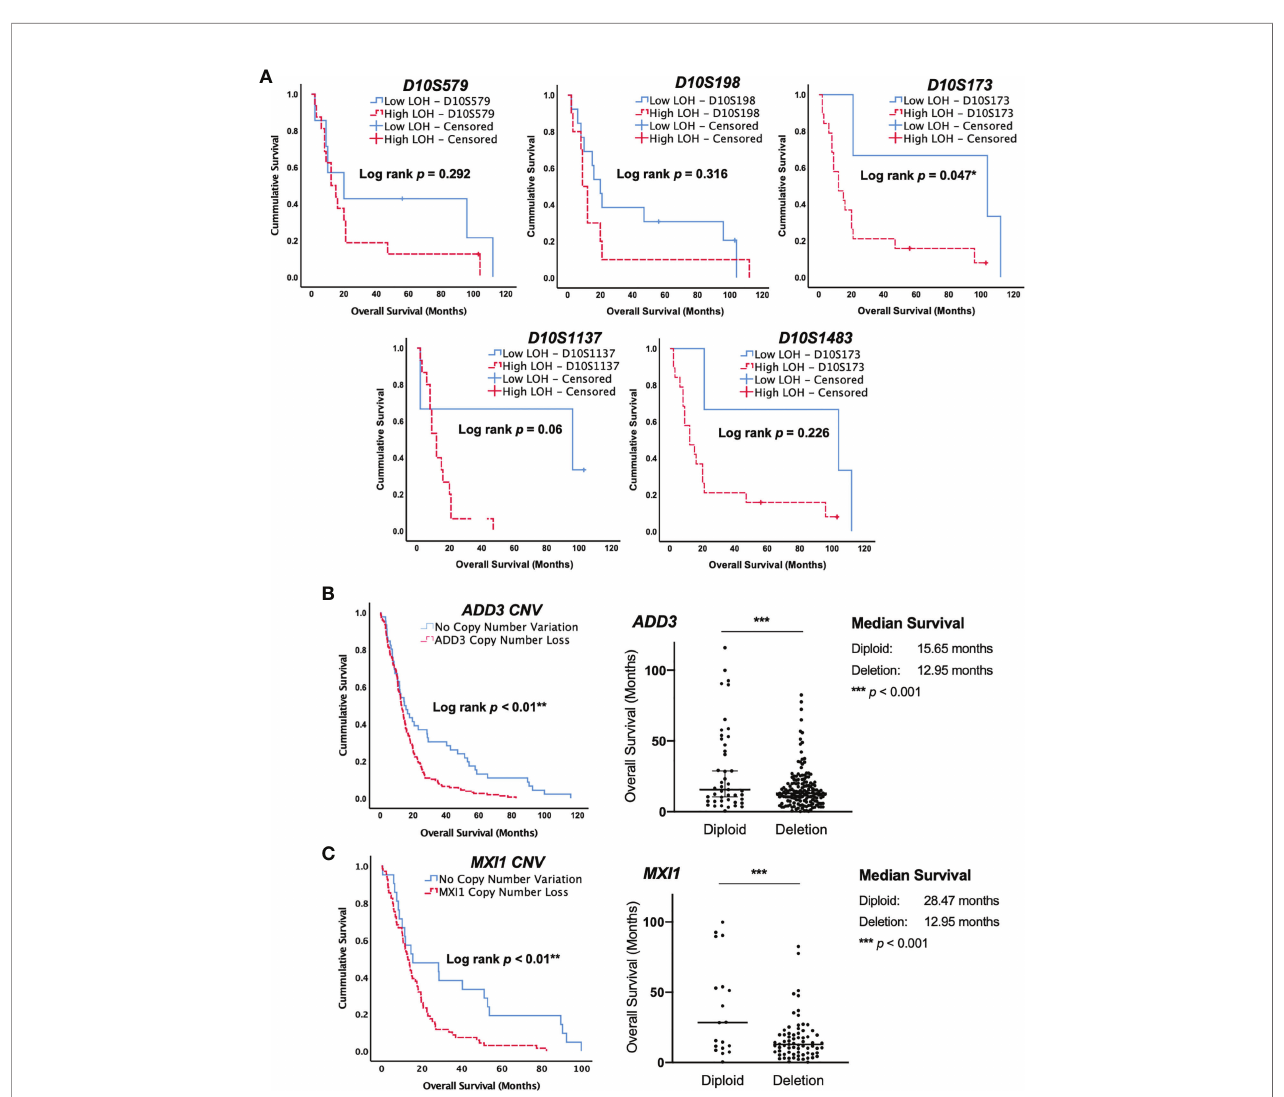
FIGURE 2 | Allelic loss at the ADD3 locus is associated with poor survival in glioblastoma (GBM). (A) Kaplan – Meier survival curve in our cohort of GBM. Allelic loss at D10S579, D10S198, D10S1483, and D10S1137 showed no signi fi cant difference in patient survival. A high level of deletion at D10S173 was statistically correlated with shorter survival compared with patients that had low-level deletion (* p < 0.05). (B, C) The Cancer Genome Atlas (TCGA) database with 203 GBM specimens was used for validation, and data were consistent with those in our cohort, suggesting that a copy number loss of ADD3 and MXI1 (D10S173) is associated with a worse clinical outcome (** p < 0.01). ADD3 copy number variation in 202 GBM and the overall patient survival. A total of 157 samples harbor copy number loss, and 45 were diploid. Median with 95% CI (*** p < 0.0001). MXI1 copy number variation in 90 GBM and the overall patient survival. A total of 71 samples harbor copy number loss, and 19 were diploid. Median with 95% CI (*** p <